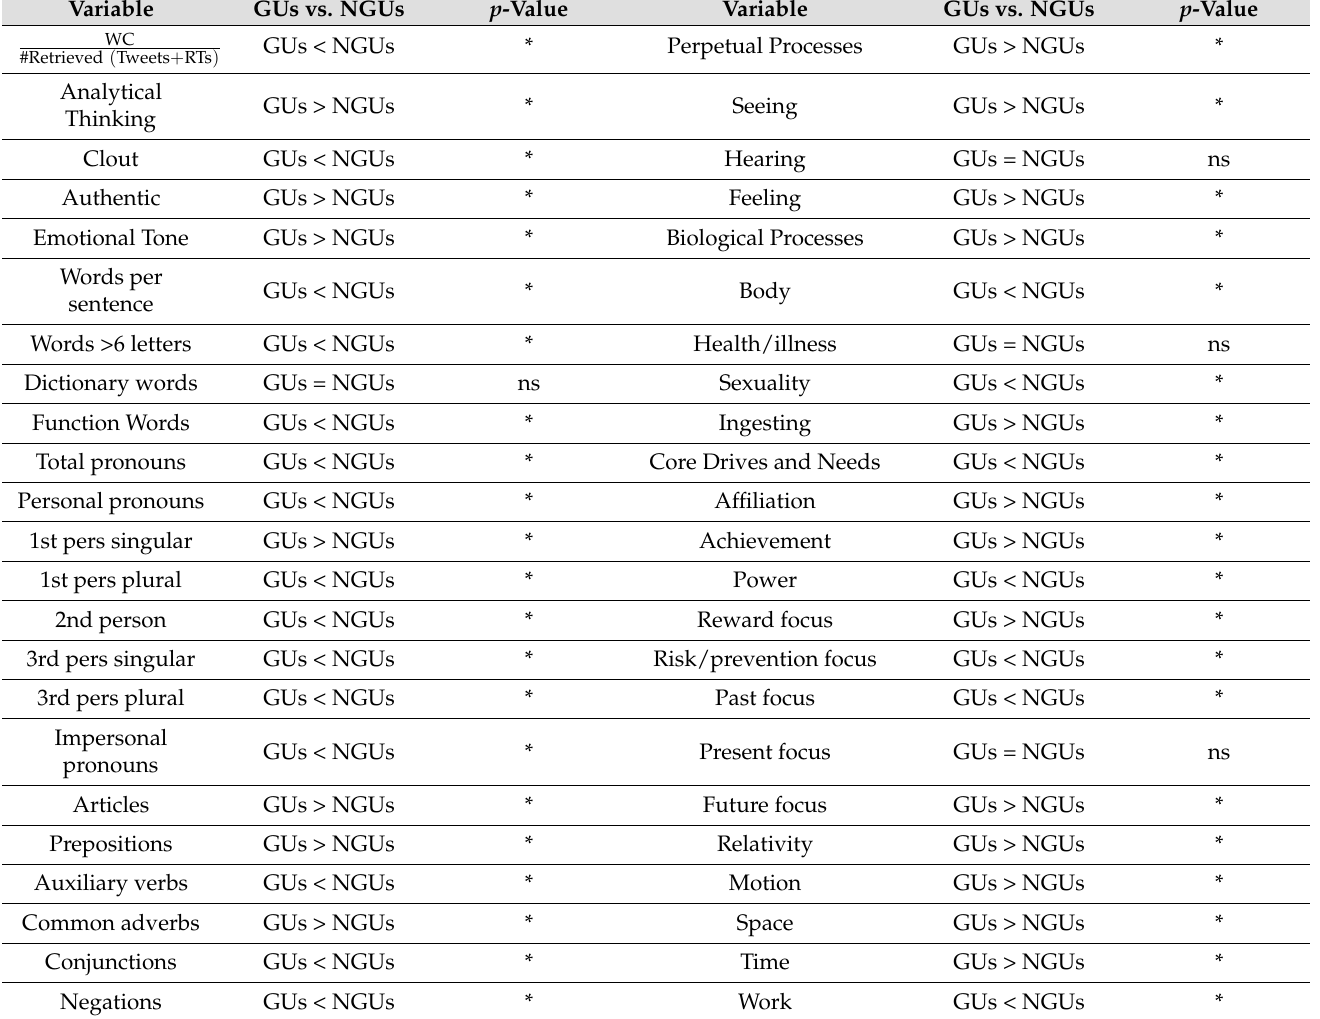
Table 5. GUs vs. NGUs based on the linguistic features of